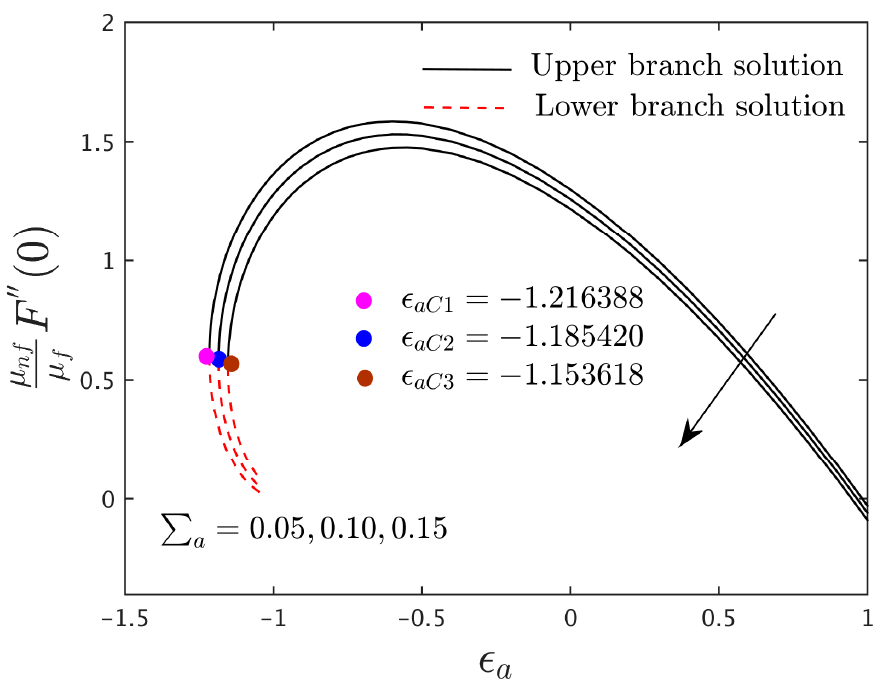
ε Figure 4. The friction factor versus ε a for the numerous values of Σ a when Pr a = 1.0, Sc a = 10.0, Figure 4. The friction factor versus a for the numerous values of Pr = 6.2, ϕ = 0.025, and γ s =